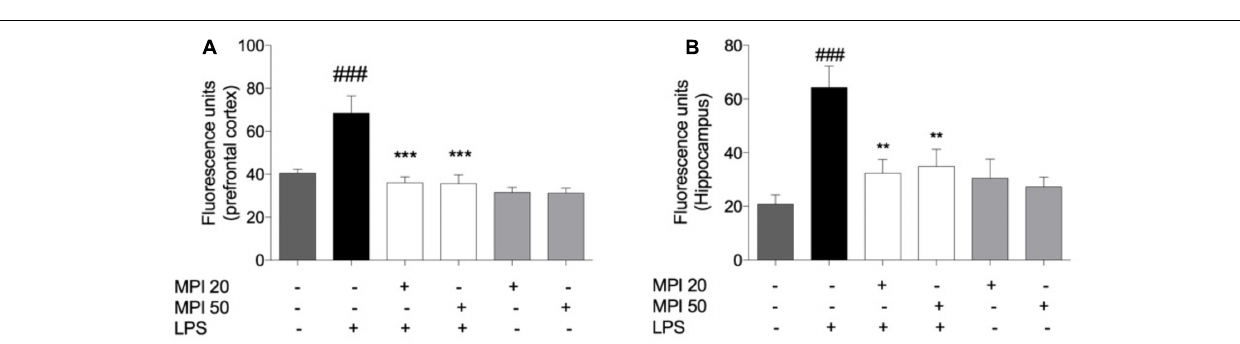
FIGURE 5 | Effect of MPI on RS formation in LPS-challenged mice. After 24 h of LPS administration, the LPS-induced group had significantly increased the RS formation in PFC (A) and HC (B) ### P < 0.001 when compared to the control group. MPI followed by LPS administration prevented the increase of RS formation in PFC ( F 5 , 30 = 4.472, P < 0.001 post hoc ∗∗∗ P < 0.001, n = 6) ( ∗∗∗ ) and HC ( F 5 , 30 = 6.317, p < 0.01, post hoc ∗∗ P < 0.01, n = 6) ( ∗∗ ) when compared to the LPS-induced group. No significant differences observed among the control and MPI followed by saline admnistration. Data were analyzed using a one-way ANOVA followed by the Student–Newman–Keuls multiple comparisons post hoc test. Error bars represent